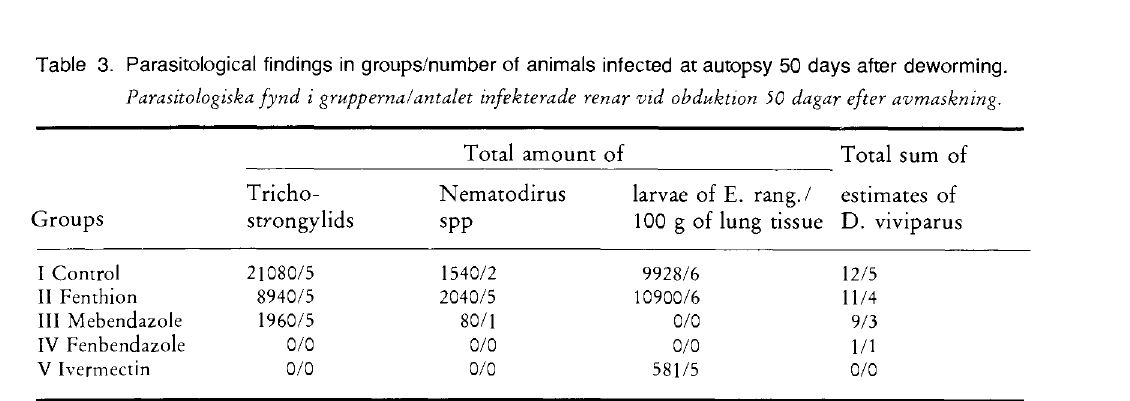
Table 3. Parasitological findings in groups/number of animals infected at autopsy 50 days after